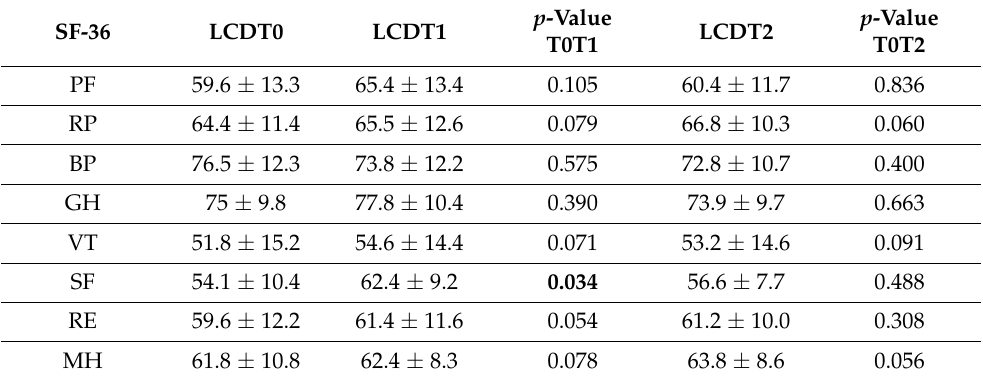
Table 6. Mean score ( ± SD) value of SF-36 test at baseline, T1 and T2 in LCD group.